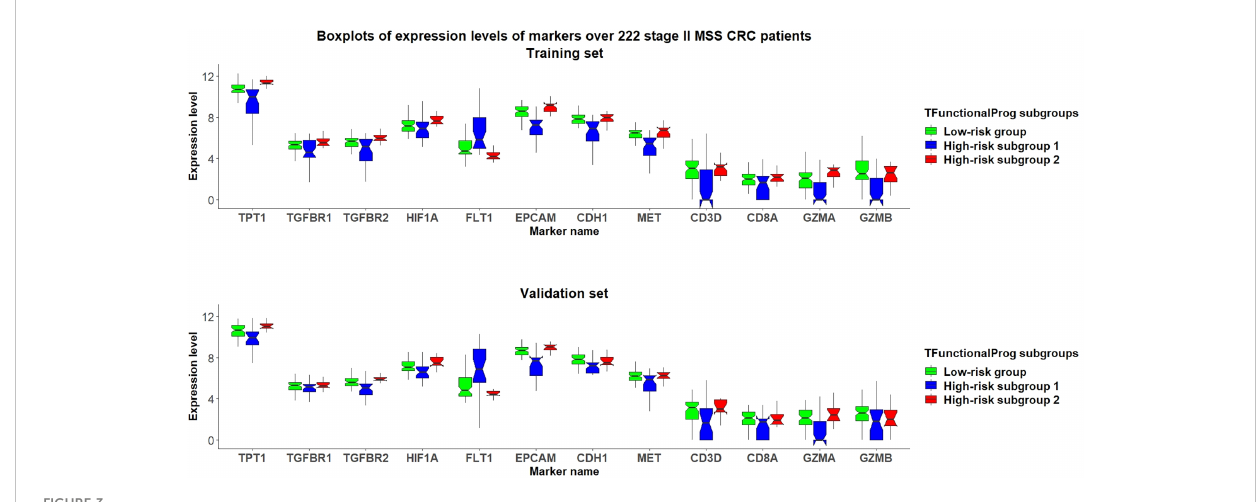
FIGURE 3 Grouped boxplots of expression levels (Y-axis) of selected markers of epithelial mesenchymal transition ( TPT1, TGFBR1, TGFBR2, FLT1 ), hypoxia ( HIF1A ), epithelial phenotype ( EPCAM, CDH1, MET ) and tumor in fi ltrating cytotoxic T cells ( CD3D, CD8A, GZMA, GZMB ) in 222 stage II MSS CRC patients divided into three subgroups: (1) TFunctionalProg low-risk group (green), (2) TFunctionalProg high-risk subgroup 1 (blue) and (3) TFunctionalProg high-risk subgroup 2 (red). The upper panel is the training set and the lower panel is the independent validation set. The tumor characters and tumor microenvironments of the two TFunctionalProg high-risk subgroups are clearly different and suggest that recurrence of stage II CRC requires transitions from multiple distinct states.